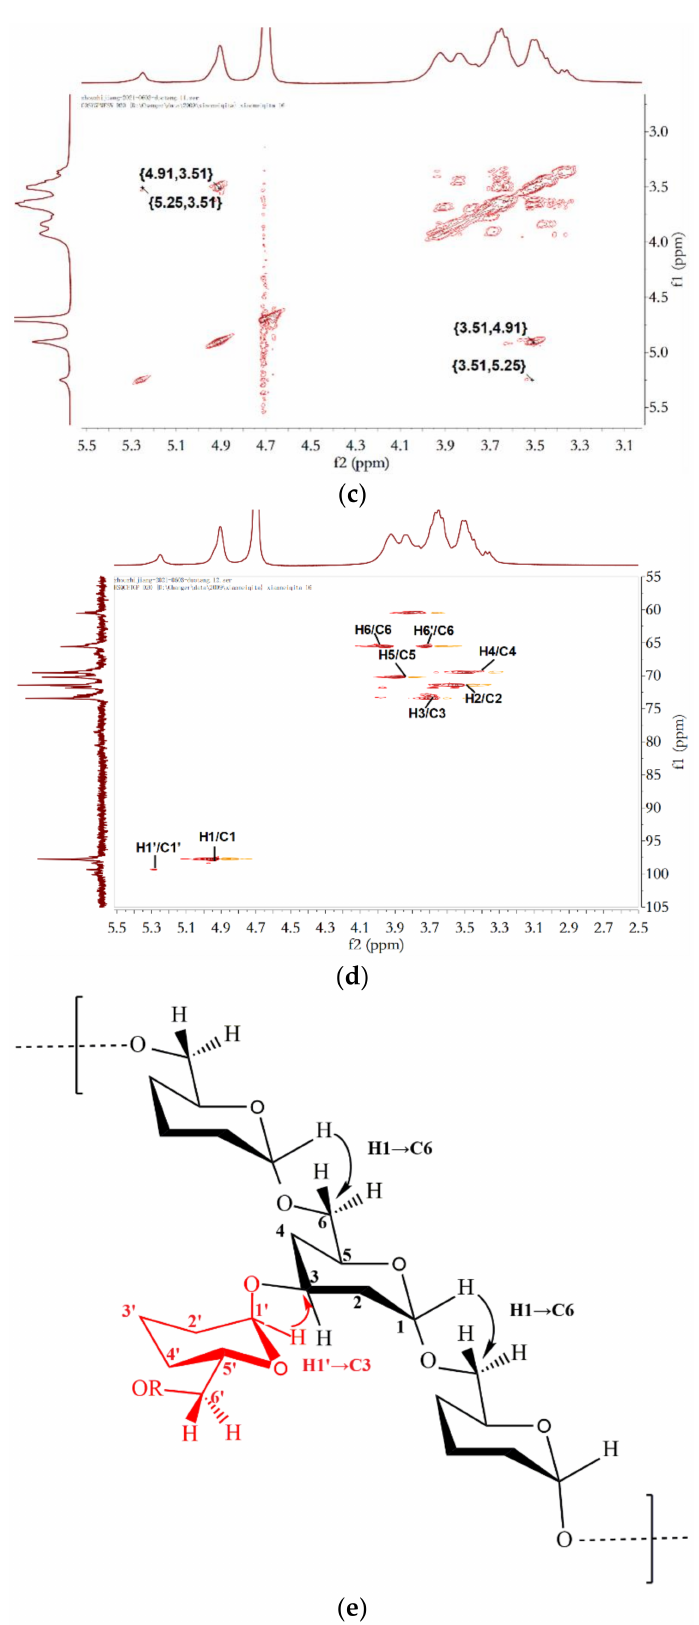
Figure 4. NMR spectra of the purified M-EPS recorded on a Bruker AVANCE 400 MHz spectrometer in D 2 O ( a ) 1 H-NMR; ( b ) 13 C-NMR; ( c ) COSY; ( d ) HSQC and the schematic diagram of the structure of M-EPS ( e